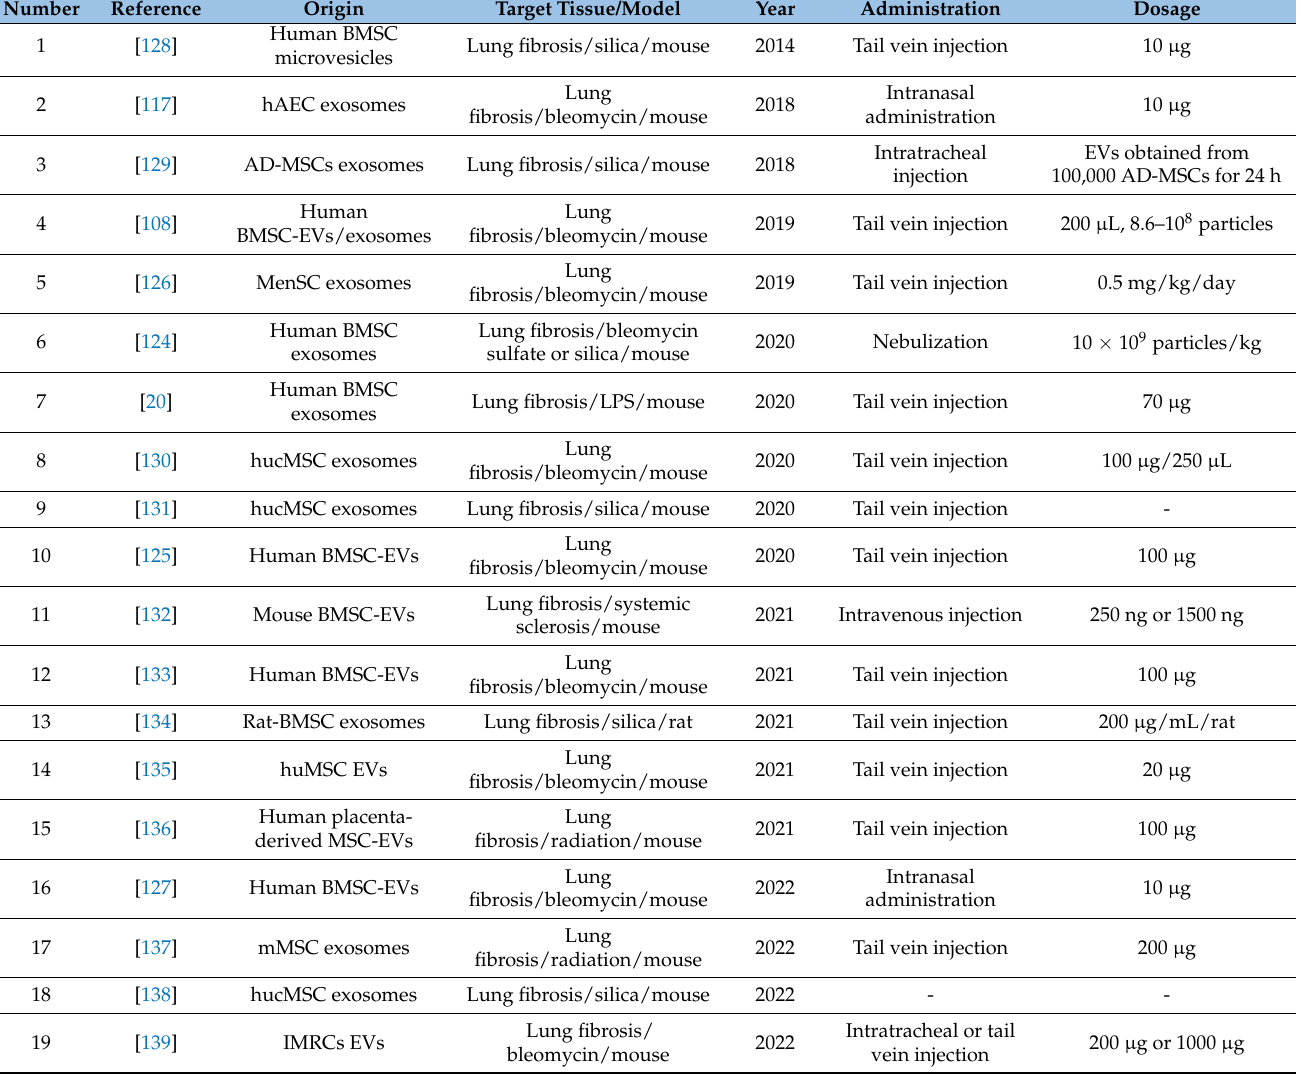
Table 2. Studies of MSC-EVs in vivo administration in lung